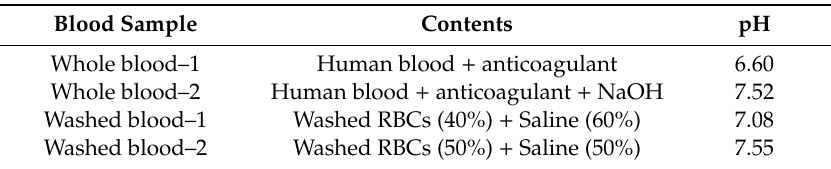
Table 2. Blood samples in this study.